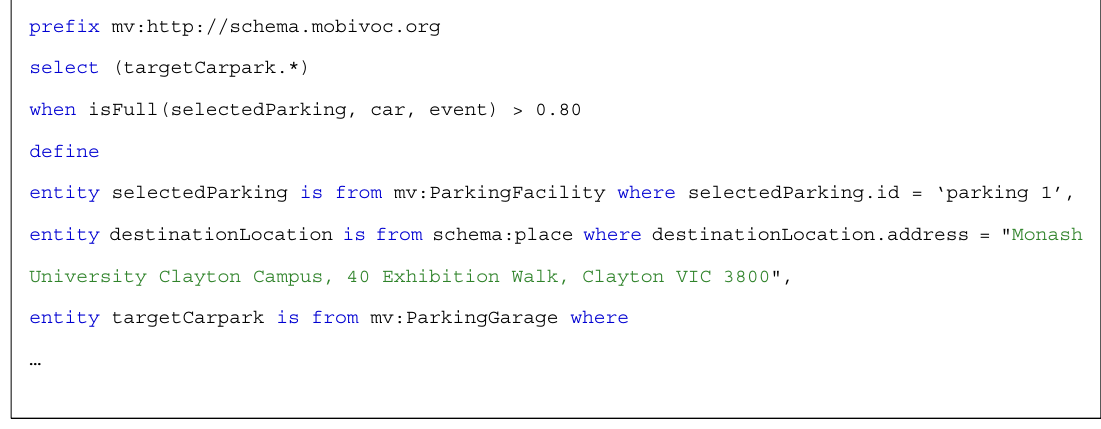
Scheme 7. Example of using WHEN clause in a CDQL query.